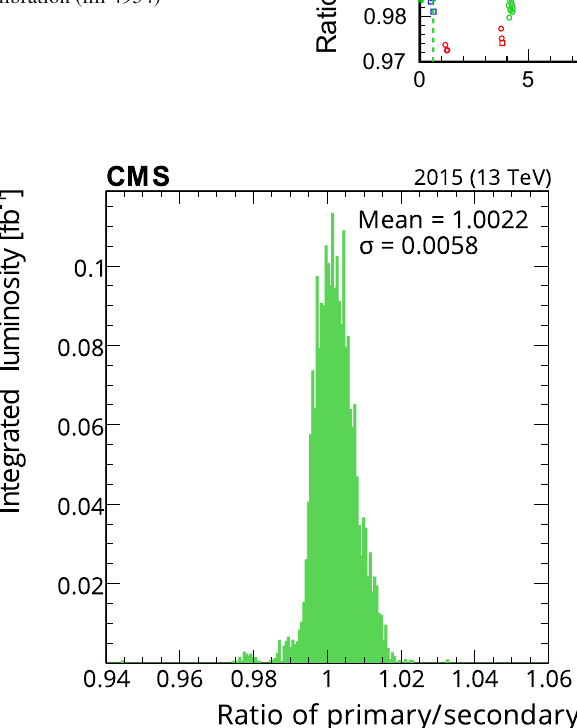
Fig. 17 The luminosity measurements from PCC, HFOC, and RAMSES are compared as a function of the integrated luminosity in 2016. Comparison among three luminometers facilitates the identification of periods where a single luminometer suffers from transient stability issues. The ratios that are plotted in red contain invalidated data. The dashed line delineates the vdM calibration (fill 4954)